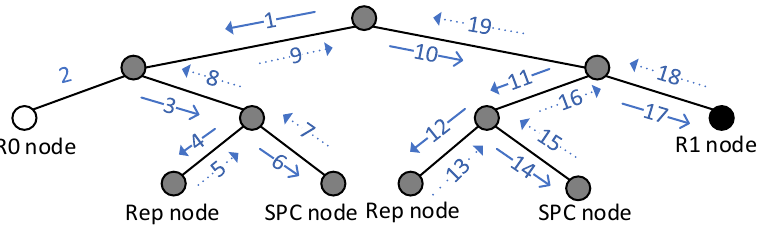
Figure 6. Schematic diagram of the decoding process based on traditional subcodes.